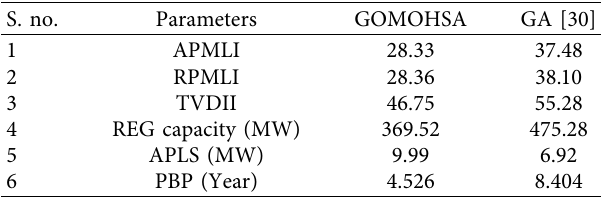
Table 15: Performance comparison of GOMOHSA and GA.